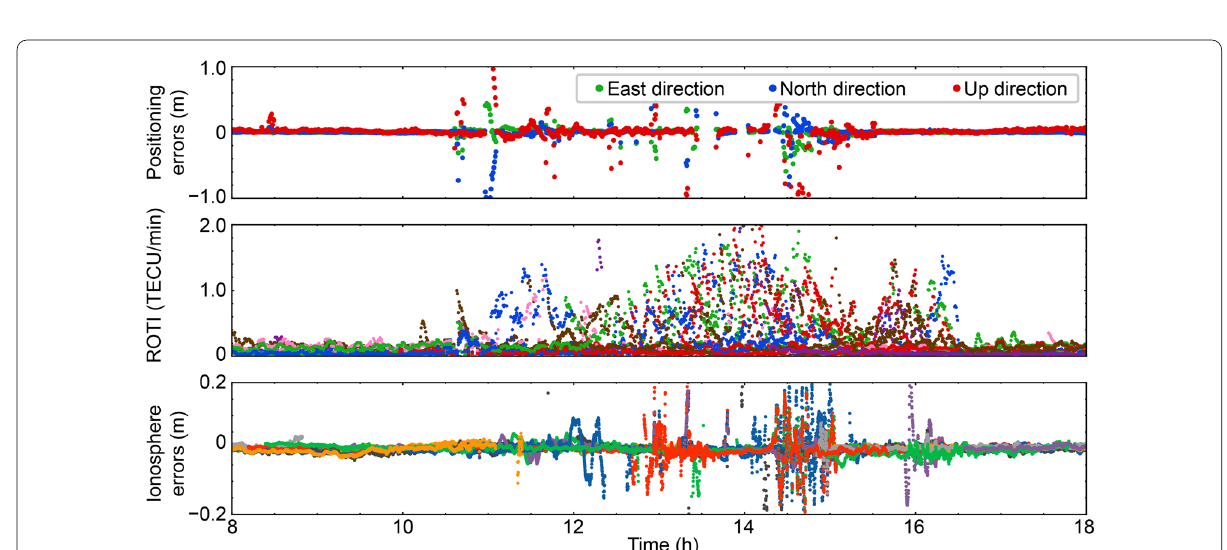
Fig. 10 Time series of PPP-RTK, ROTI, and interpolated ionosphere errors at HKSC station in Hong Kong,